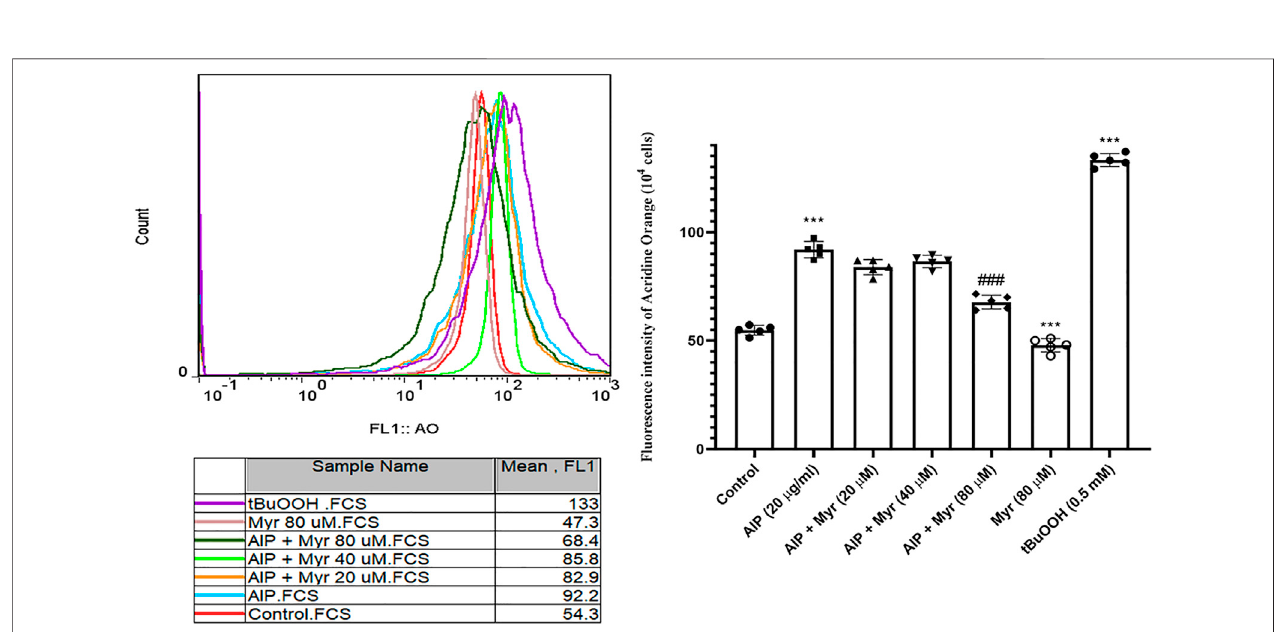
FIGURE 4 | Myr inhibits AlP-induced lysosomal dysfunction in isolated cardiomyocytes. Isolated cardiomyocytes were treated or cotreated with the indicated concentrations (20 μ g/ml) of AlP and Myr (20, 40, and 80 µM) for 3 h. Lysosomal membrane stability was examined after incubation using acridine orange fl uorescence dye. Data are mean ± SD ( n (cid:2) 3) of three independent experiments. *** p < 0.001 signi fi cantly different from control, ## p < 0.01 signi fi cantly different from AlP-treated cardiomyocytes, one-way ANOVA, Tukey ’ s test. Myr, myricetin; AlP, aluminum phosphide; AO, acridine orange; t -BuOOH, tert -butyl hydroperoxide.